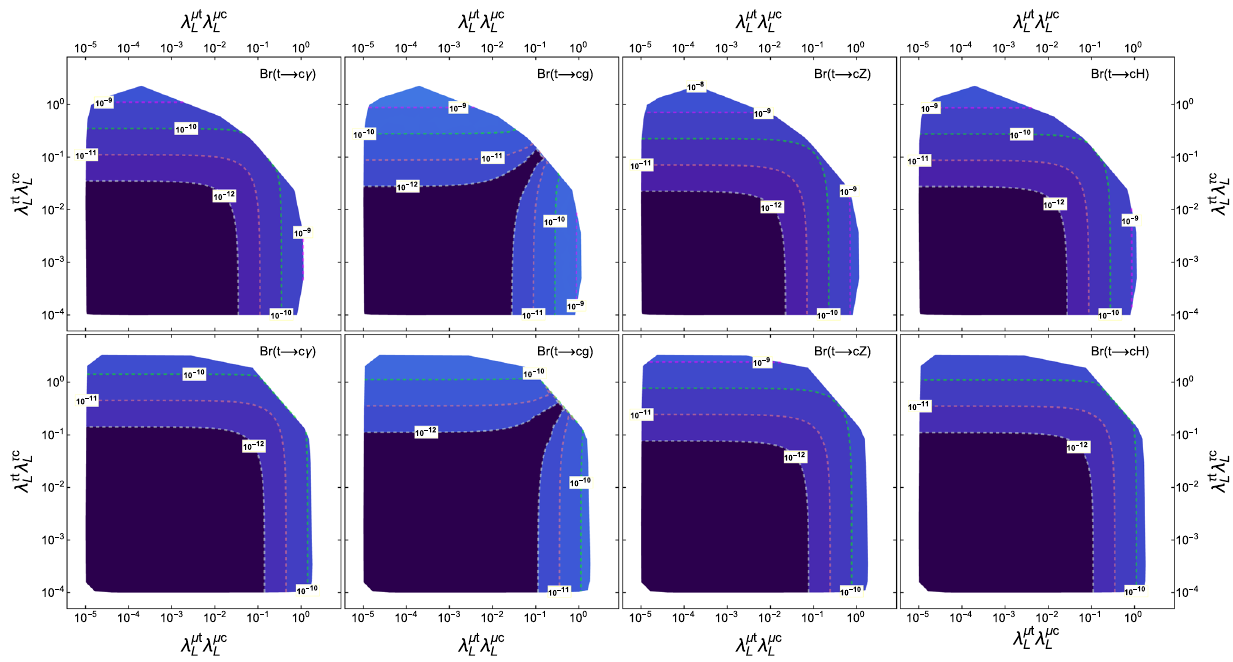
Fig. 9 Contours of the branching ratios of the t → cX decays for = 1000 (top plots) and 2000 GeV (bottom plots) in the λ μ t m Ω 5 / 3 μ c λ τ c ,λ μ t ,λ τ c ,λ τ t ) values inside the area allowed vs λ τ t plane for (λ L L L L L L